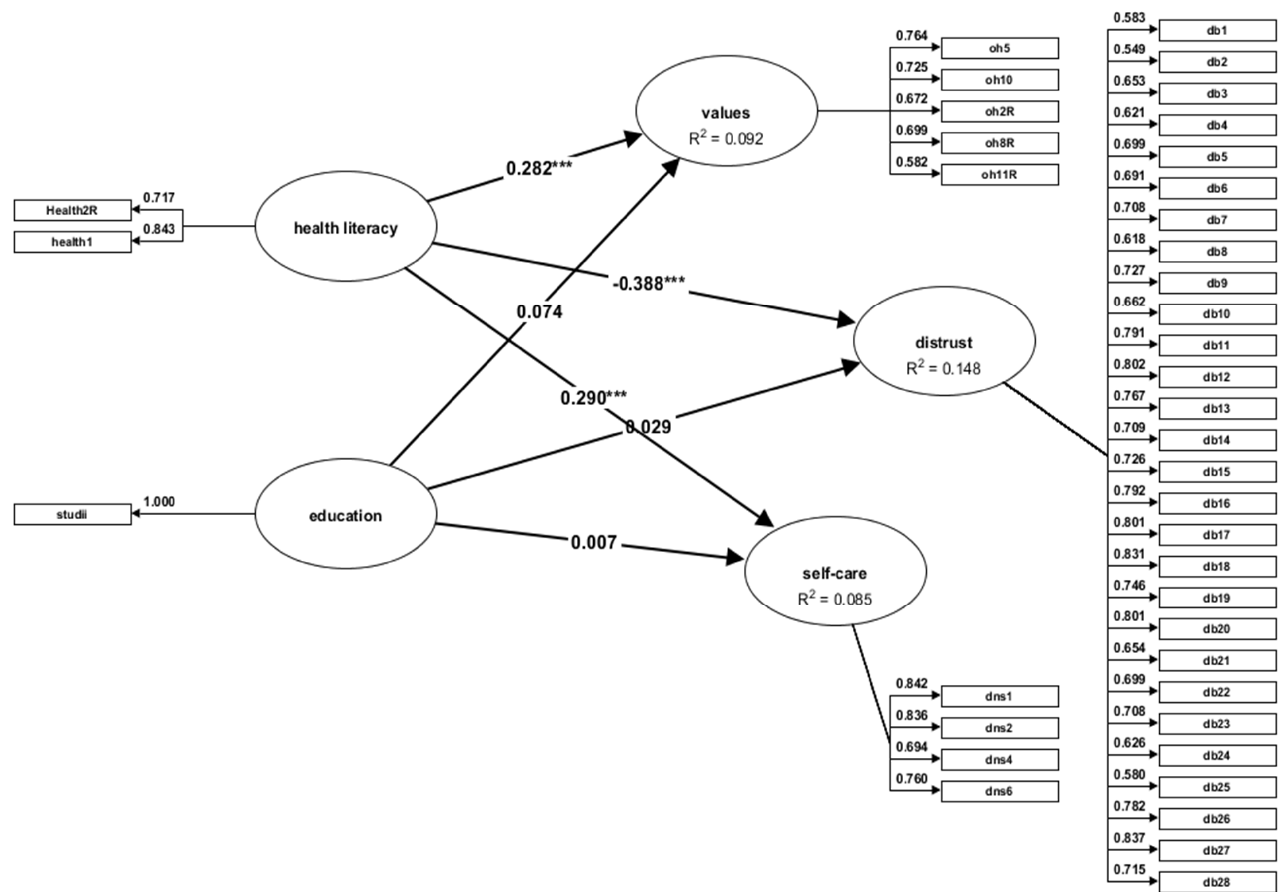
Figure 2. Structural equation model - female sample; *** p = 0.000.